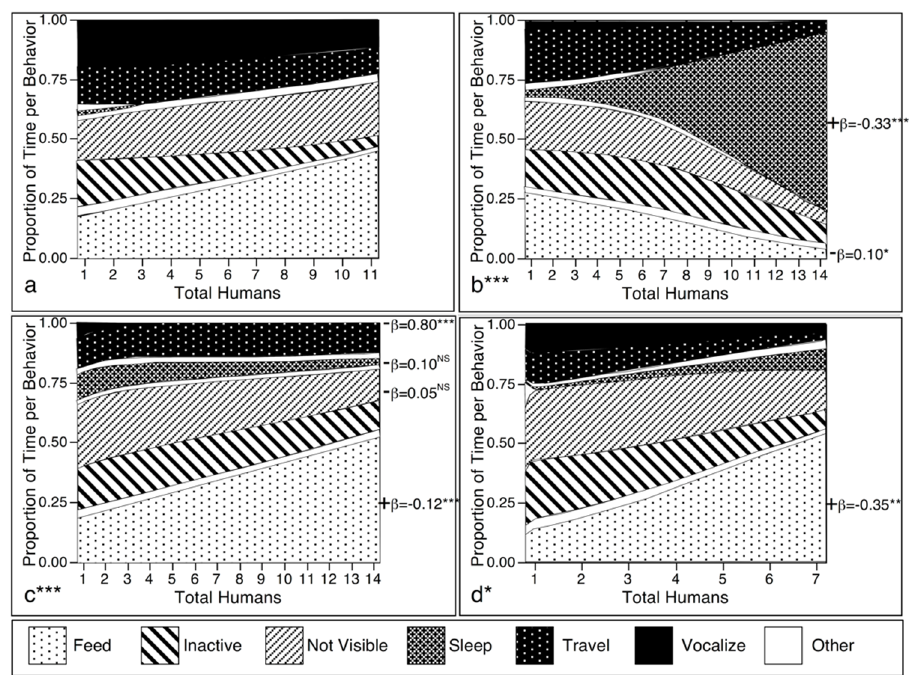
Figure 2. Behaviors at varying numbers of humans present for ( a ) Group A; ( b ) Group B; ( c ) Group C; and ( d ) Group D. Some behaviors occurred infrequently to such a degree that the analyses performed could not detect any change, so these behaviors were not independently analyzed Only behaviors that occurred frequently enough for an affect to be detected are shown. The area between the curves predicts the proportion of time the gibbon spends on each behavior. Behaviors correspond to key at bottom of the figure. Individual behaviors that changed significantly with changing numbers of humans are indicated with either a + (behavior increases in frequency as number of humans increase) or a − (behavior decreases in frequency as number of humans increases). For p values, NS: <0.1, *: <0.05, **: <0.01, ***: